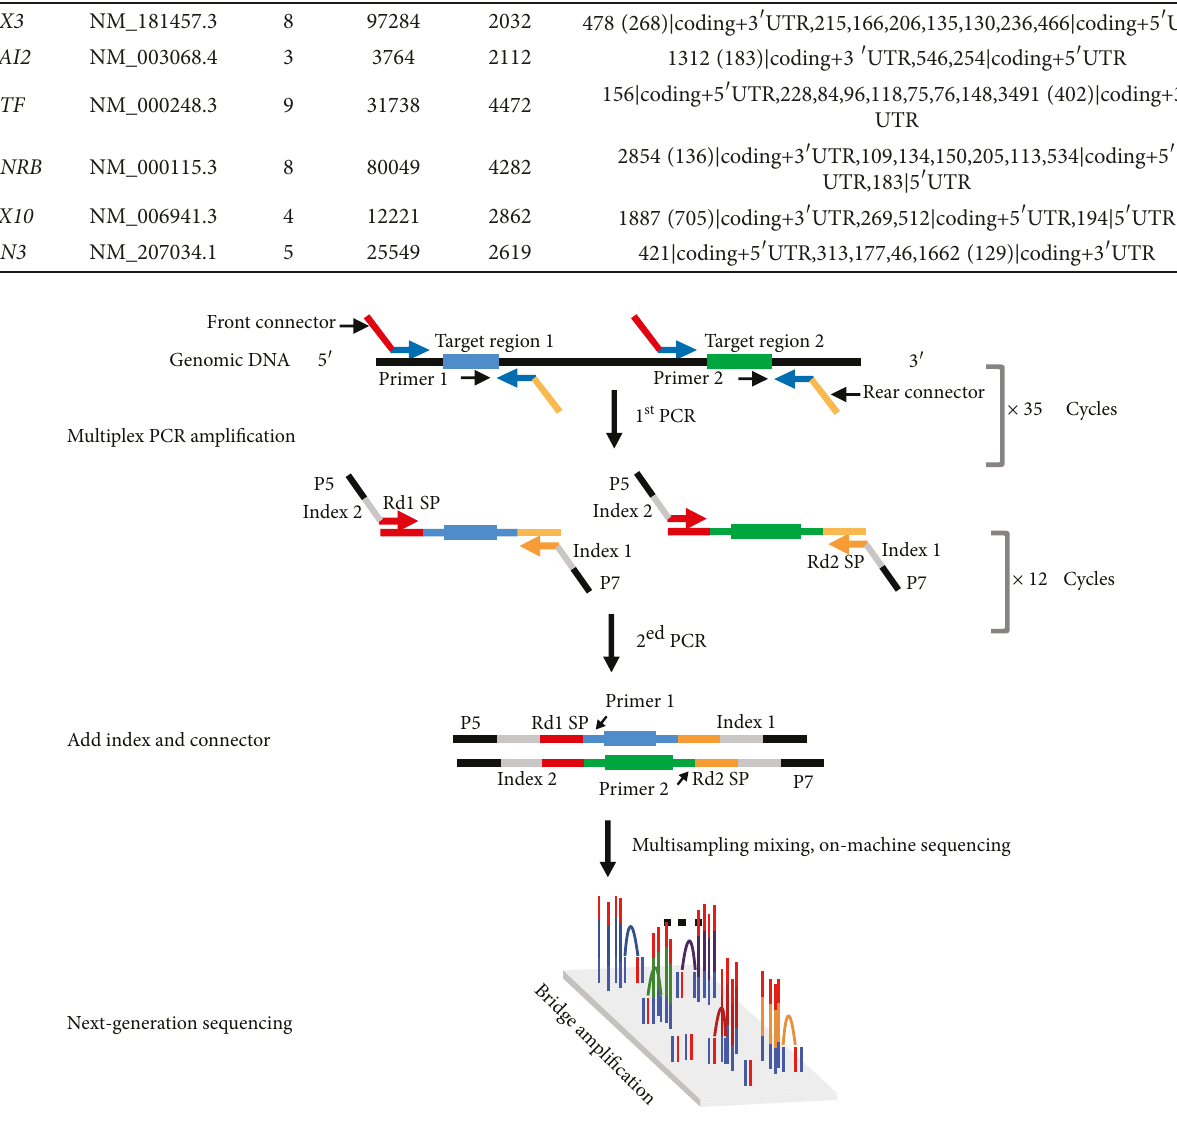
Figure 2: Multiple PCR target enrichment and next-generation Sequencing of WS-related